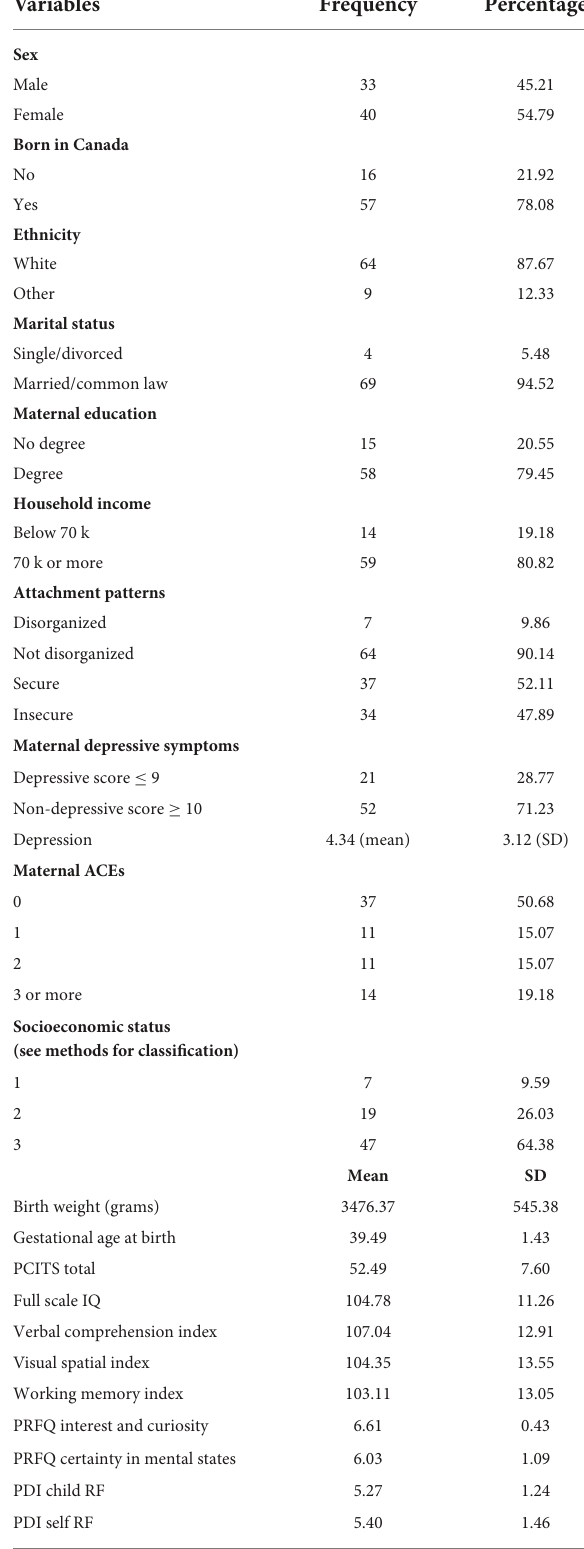
TABLE 1 Sample demographic and descriptive